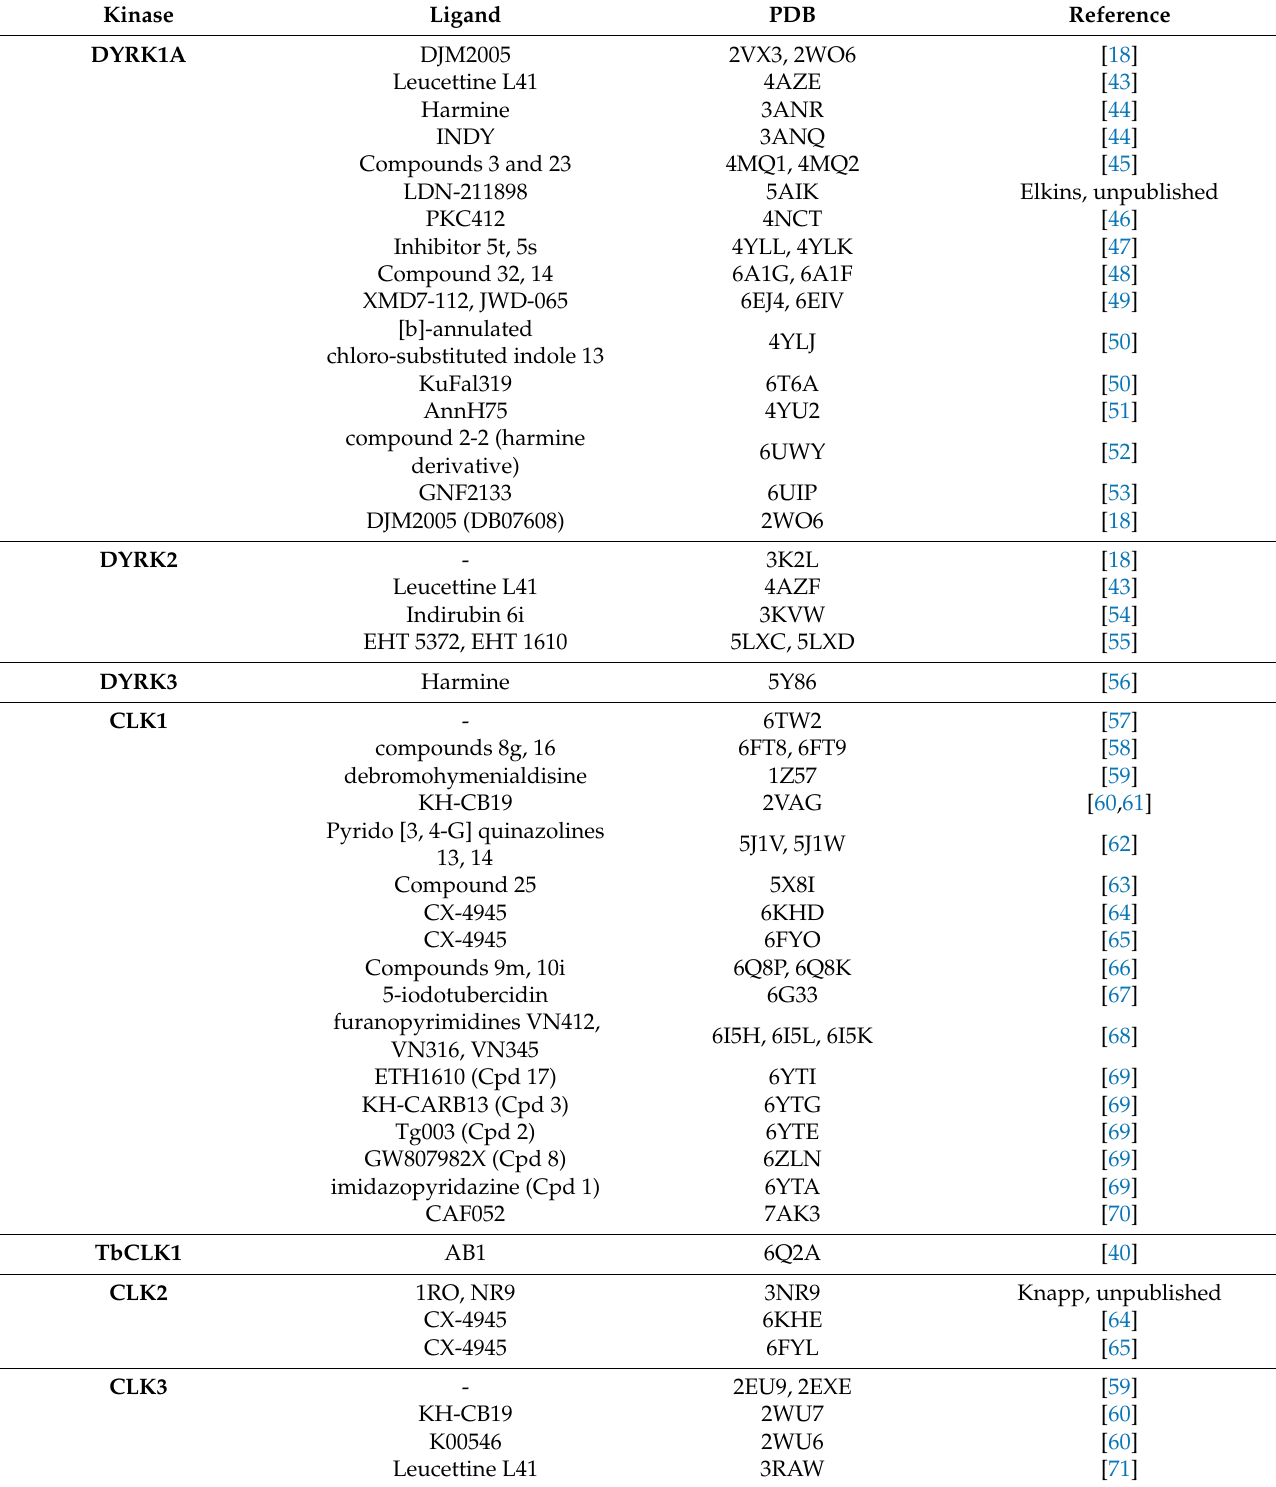
Table 2. Crystal structures of DYRKs and CLKs alone or in complex with inhibitors.